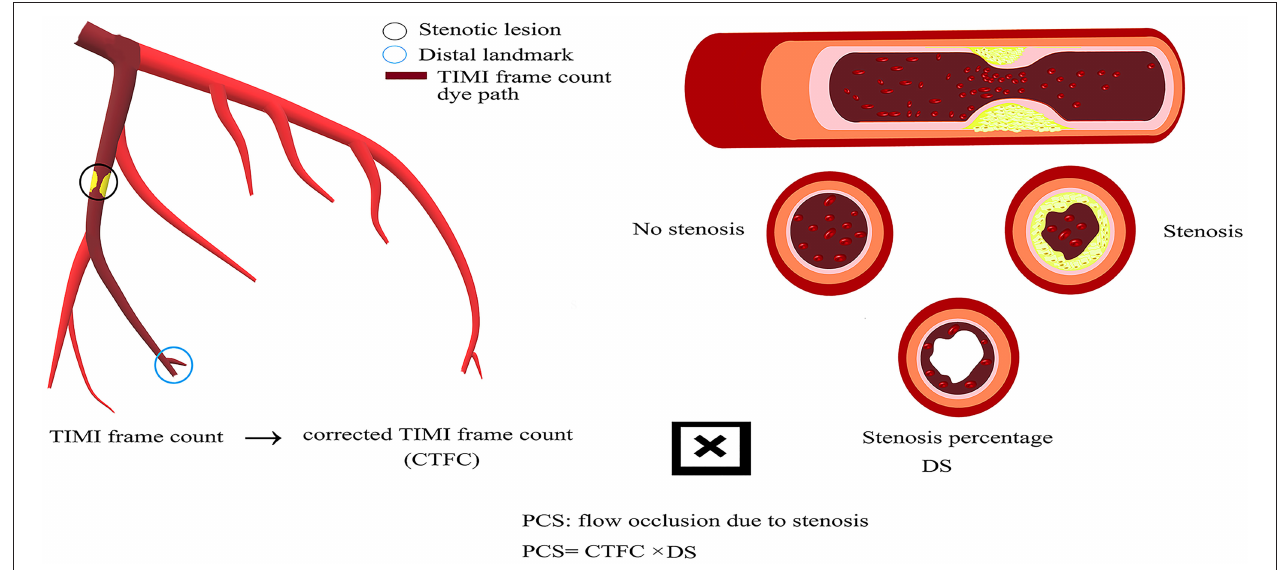
FIGURE 1 | The calculation method of